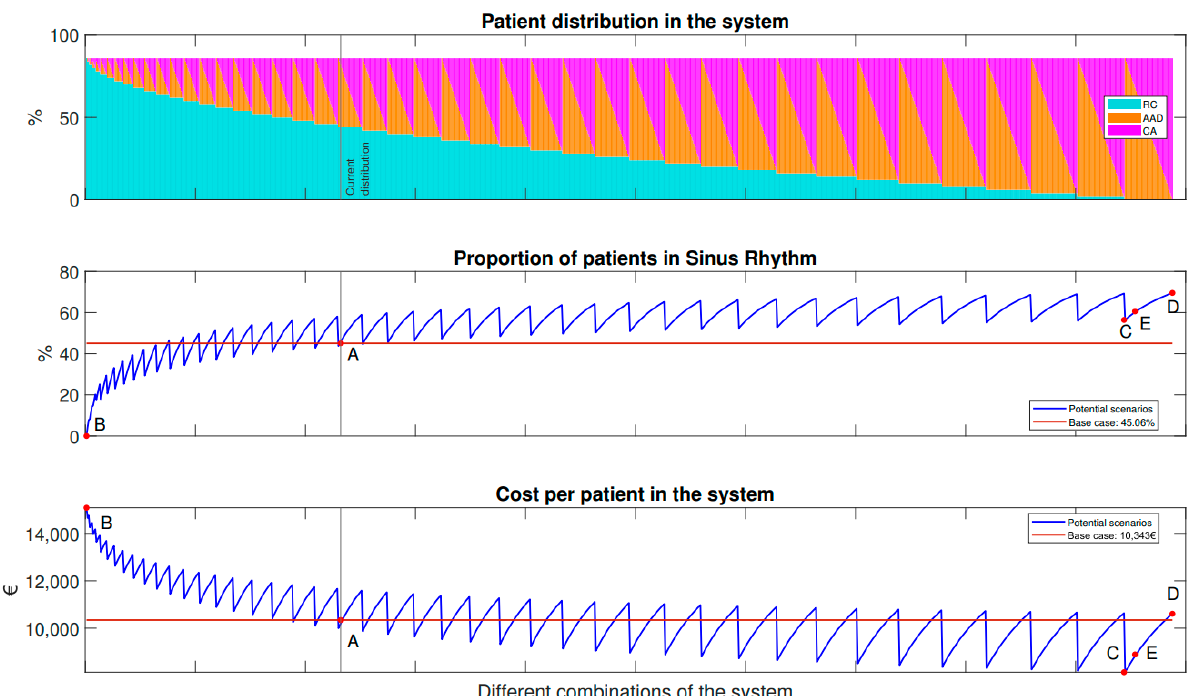
Figure 3. Representation of potential situations with their total costs and final percentage of patients in SR.